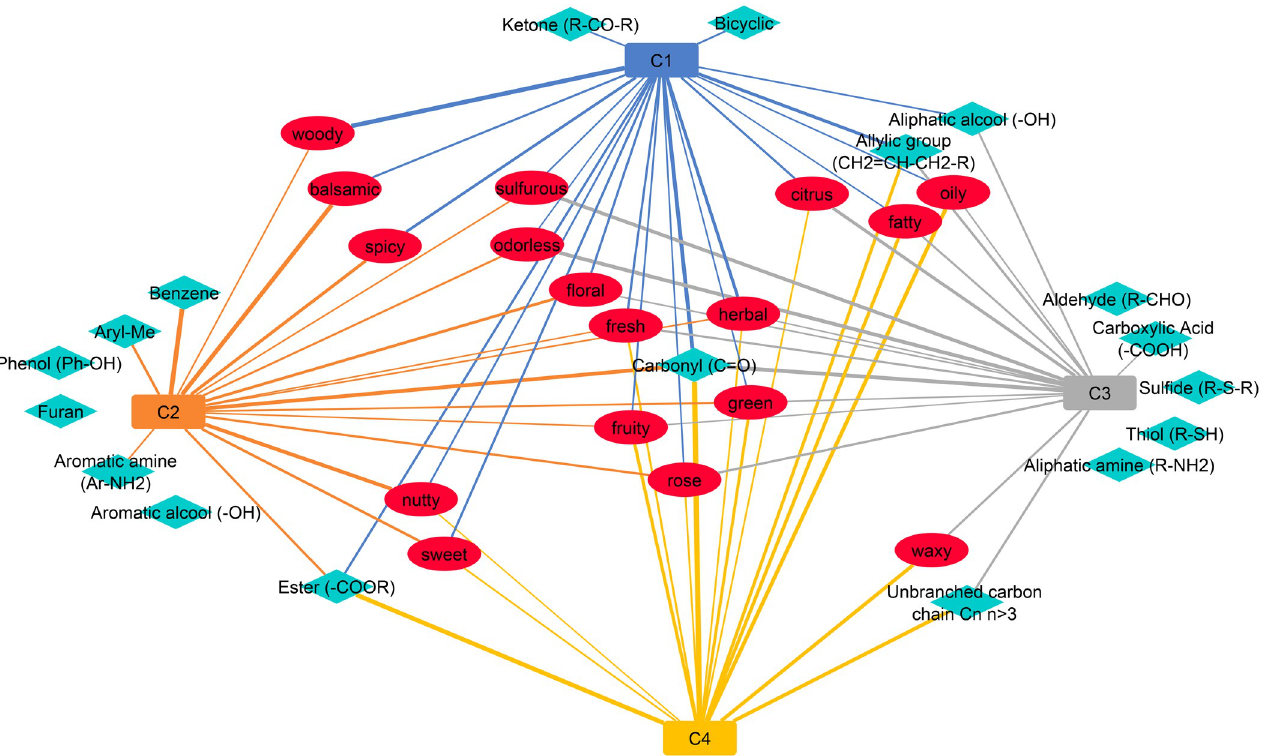
Fig 7. Network representation of the links between odor notes (red ellipse) and chemical functional groups (blue diamond). The nature of the line varies as a function of the relative frequency of occurrences. The thicker the line, the higher is the number of occurrences of an odor note or a chemical functional group within the cluster to which it is linked. The edges are invisibly for the relative frequency of occurrences less than 0.1. The blue, orange, grey and yellow rectangles correspond respectively to clusters 1, 2, 3 and 4. The blue lines correspond to the associations between the cluster 1 and the odor notes or the cluster 1 and the chemical functional groups. The orange lines correspond to the associations between the cluster 2 and the odor notes or the cluster 2 and the chemical functional groups. The grey lines correspond to the associations between the cluster 3 and the odor notes or the cluster 3 and the chemical functional groups. The yellow lines correspond to the associations between the cluster 4 and the odor notes or the cluster 4 and the chemical functional groups.